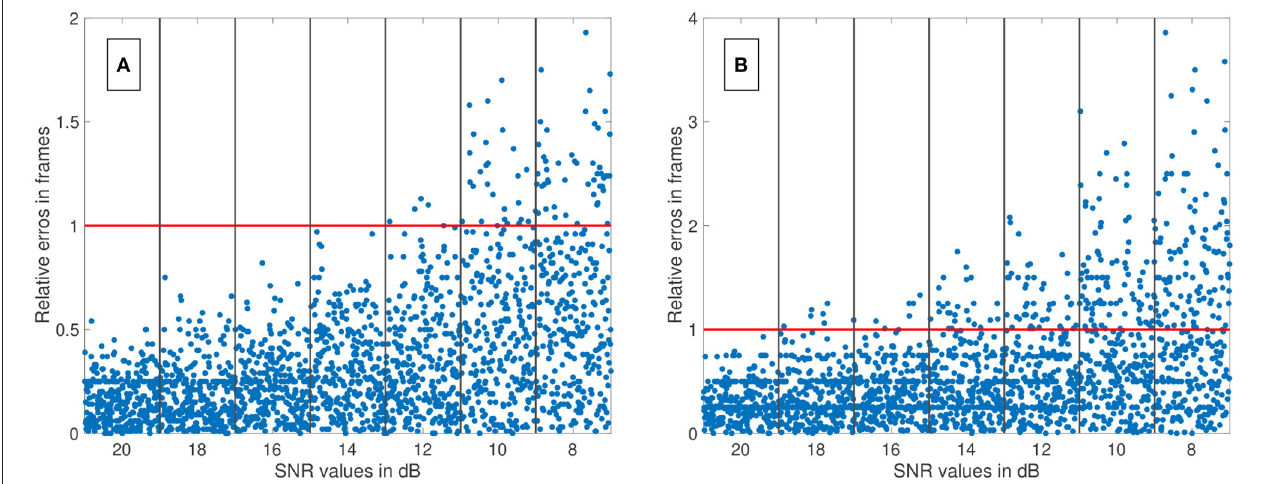
FIGURE 12 | (A) The relative error of all data sets ( f sampling 25 fps ) is shown in relation to the signal-to-noise ratio (SNR). The red line indicates the relative error of = one frame. The blue dots show the single results obtained by the fitting the Local Density Random Walk (LDRW) model to the data cut at 40 % by the cut method 1 and using its first derivative as input for the cross-correlation. The distribution of the dots within a column is irrelevant. All data sets had a relative error of less than one frame for SNR larger than 12 dB . (B) The relative error of all data sets ( f sampling 60 fps ) is shown in relation to the SNR. The red line indicates the relative error of one = frame. The blue dots show the single results obtained by the fitting the LDRW model to the data cut at 40 % by the cut method 1 and using its first derivative as input for the cross-correlation. The distribution of the dots within a column is irrelevant. All data sets had a relative error of less than one frame for SNR larger than 18 dB .